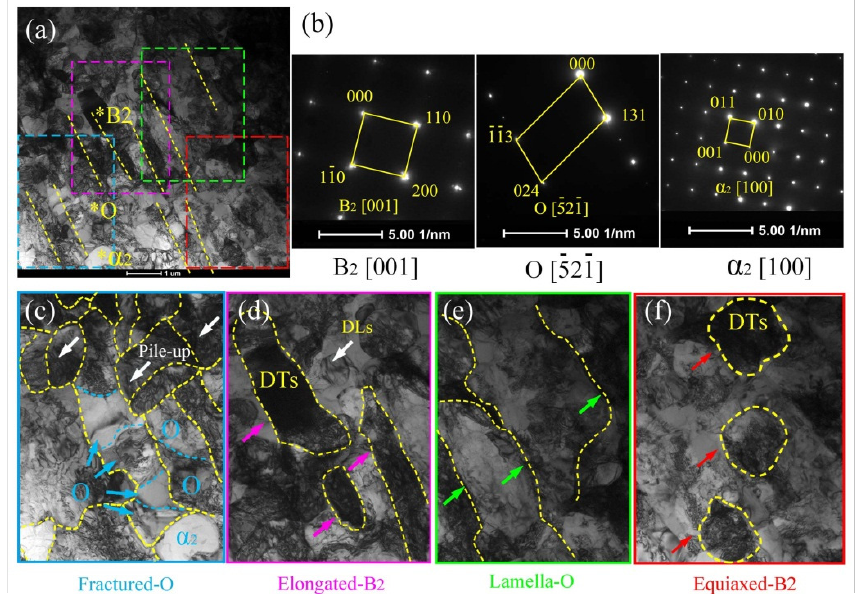
Figure 11. TEM result of the 3rd pass spun tube ( ψ t = 49%): ( a ) bright field figure, ( b ) selected area electron diffraction of ( a ), ( c – f ) local enlarged figure with three features of ( a ). The position marked by * corresponds to the diffraction pattern of Figure 11b.